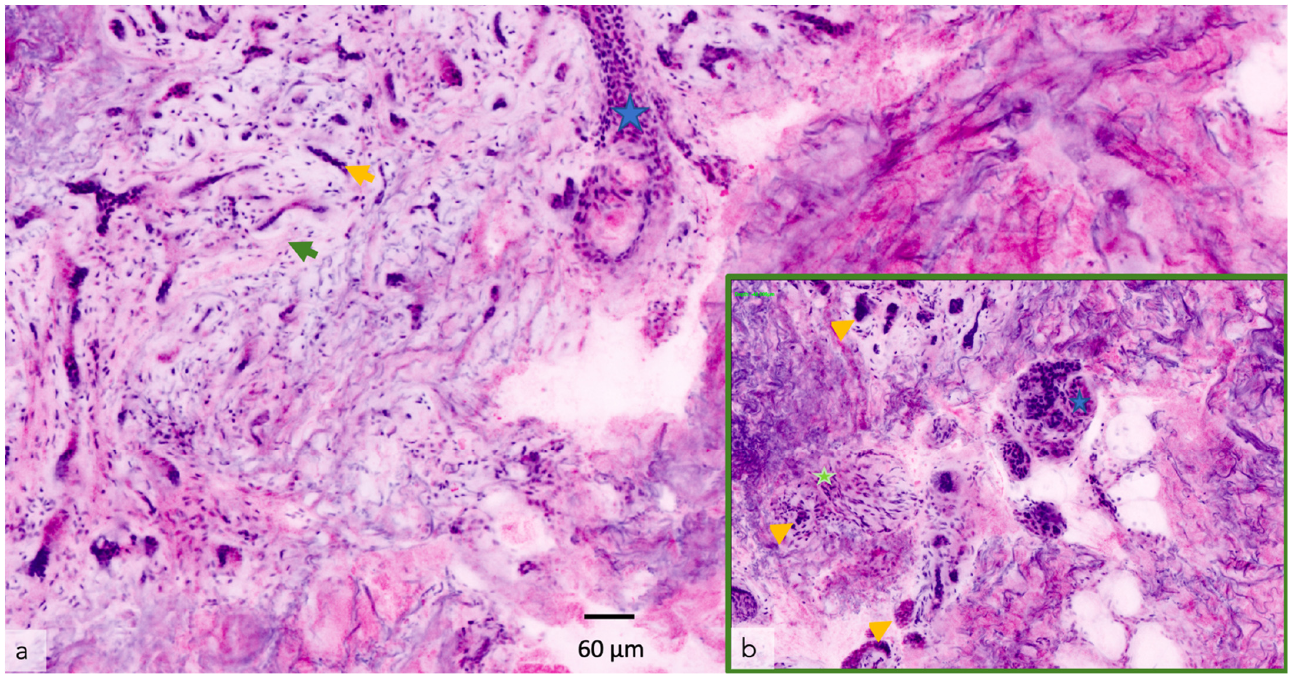
Figure 9. Ex vivo confocal microscopy of infiltrating basal cell carcinoma with peri neural invasion. Image captured with VIVASCOPE 2500 ® : ( a ) Yellow arrow: Tumor islands; Green arrow: Stromal reaction; Blue star: Hair follicle; ( b ) Green star: Nerve; Yellow arrow: Tumor islands; Blue star: eccrine ducts.